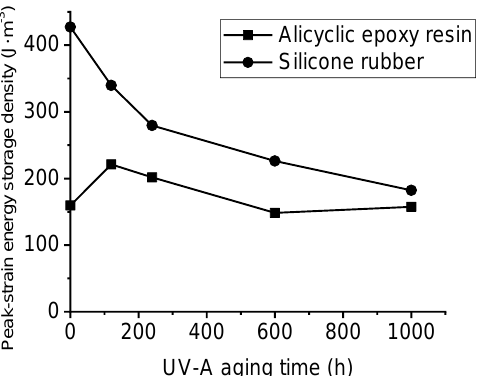
Figure 8. Comparison of the peak strain energy density of two samples at different UV-A aging time.